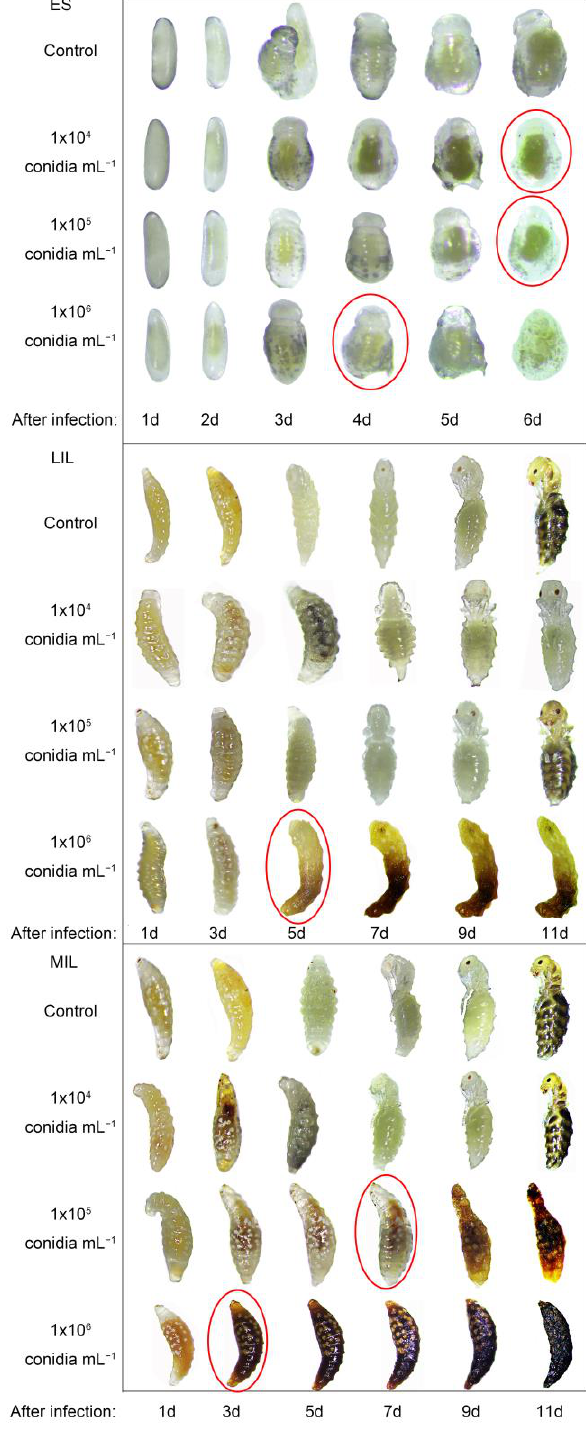
Figure 6. Infestation of pathogens against offspring of S. guani under different concentrations of B. bassiana spore suspensions. The red circle indicates that the larva has died. ES: egg of S. guani ; LIL: late instar larval; ML: mature larval.